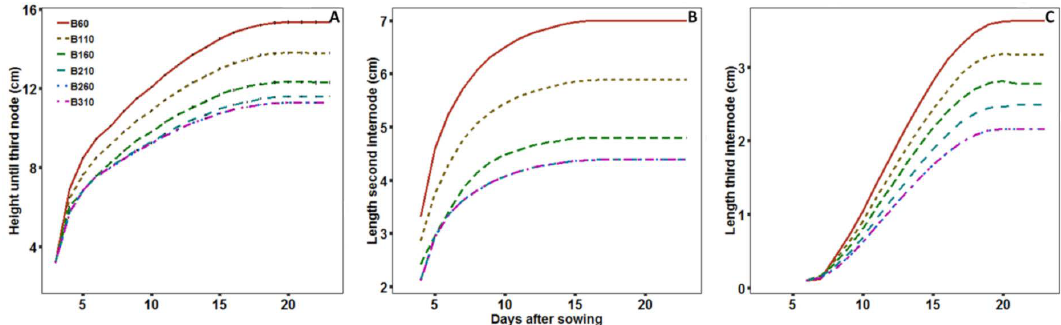
Figure 5. Simulated height until the third node ( A ) and length of second ( B ) and third ( C ) internode with a reflective surface of pots, soil and bottom.